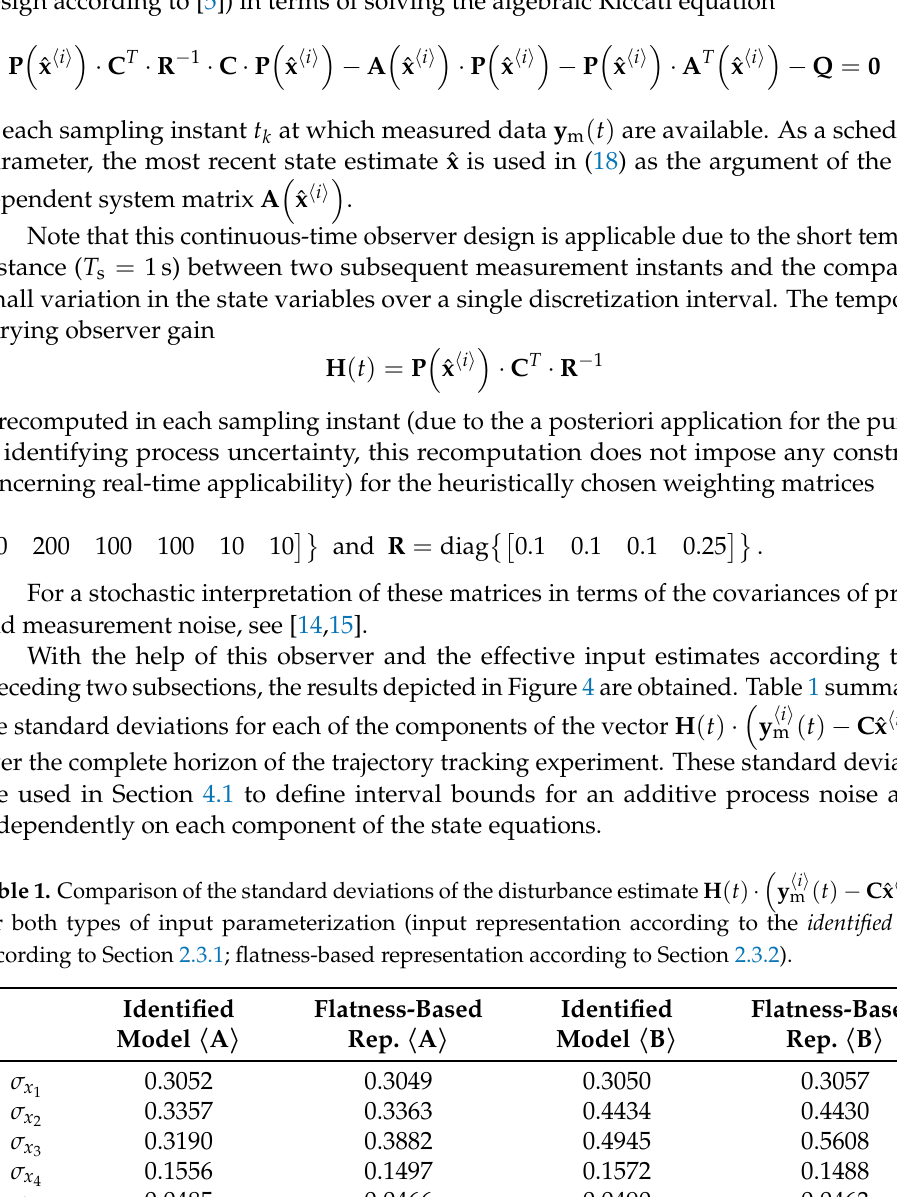
(cid:16) (cid:17) (cid:104) i (cid:105) ( t ) − C ˆ x (cid:104) i (cid:105) ( t ) y m